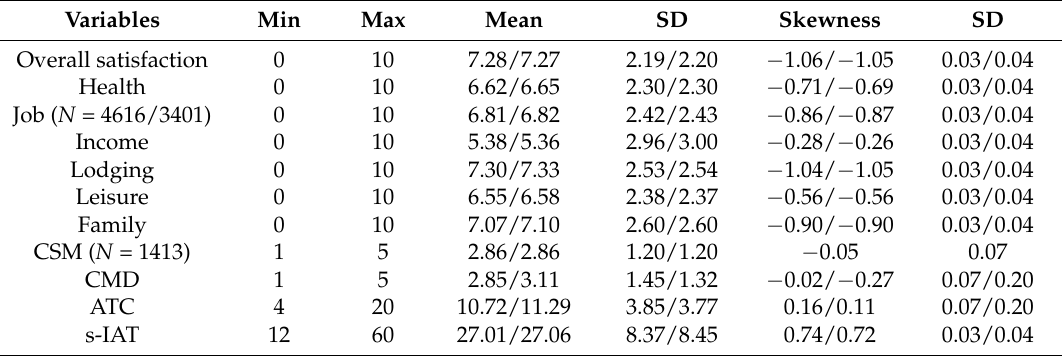
Table 1. Means and Standard Deviation, Minimum, Maximum and Skewness for life satisfaction variables, and Internet variables for the complete sample (CS) and non-commuters